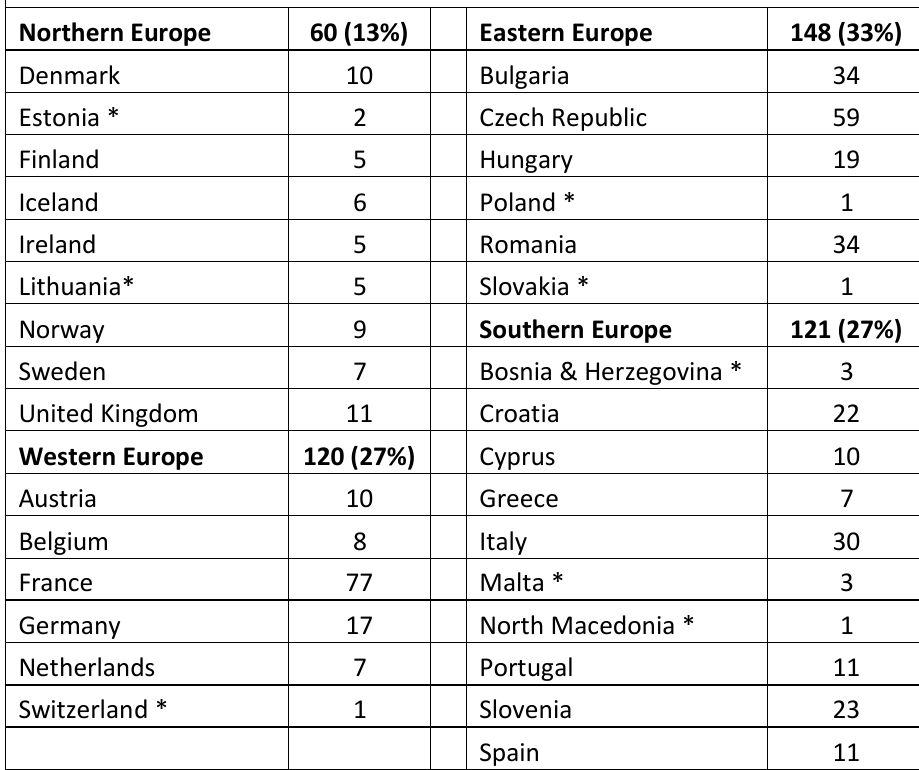
Table 2 : Regional distribution of respondents from Europe (N =